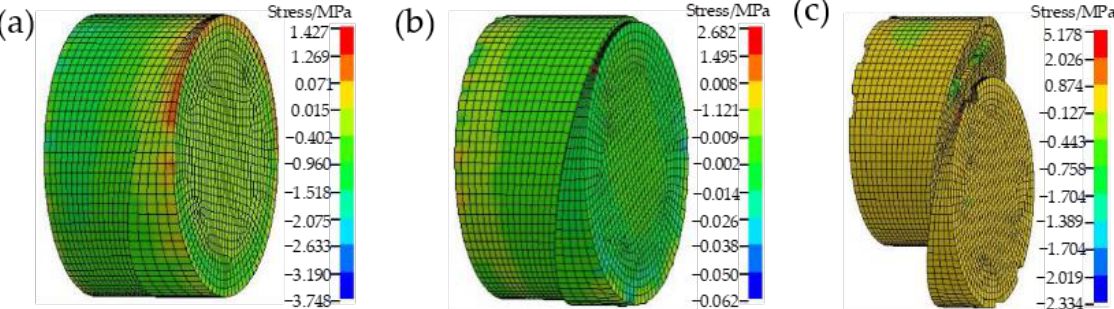
Figure 18. Stress distribution nephogram of 13° layered filling body: ( a ) failure time of 0.6 ms; ( b ) failure time of 1.1 ms; ( c ) failure time of 9.4 ms.